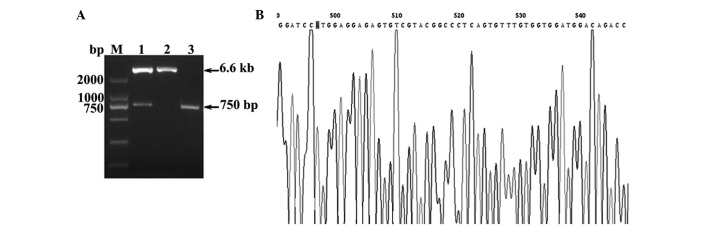
(A) Identification of recombined lentiviral vector, pLenti-LIGHT. M, DL2000 DNA marker; Lane 1, plasmid pLenti-LIGHT digested with SalI and BamHI; lane 2, plasmid pLenti digested with SalI and BamHI; lane 3, PCR products of LIGHT; LIGHT, lymphotoxin-related inducible ligand that competes for glycoprotein D binding to herpesvirus entry mediator on T cells. (B) Sequencing histograms of pLenti-LIGHT.